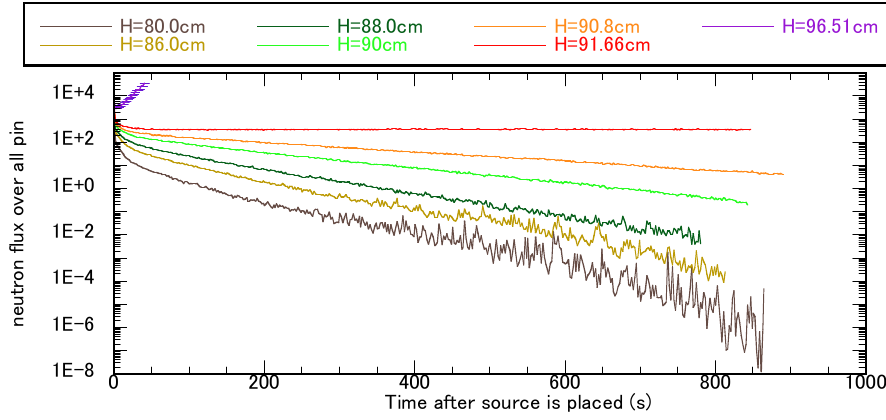
Figure 2. TDPI simulations: neutron flux variation with time from a source at core center.